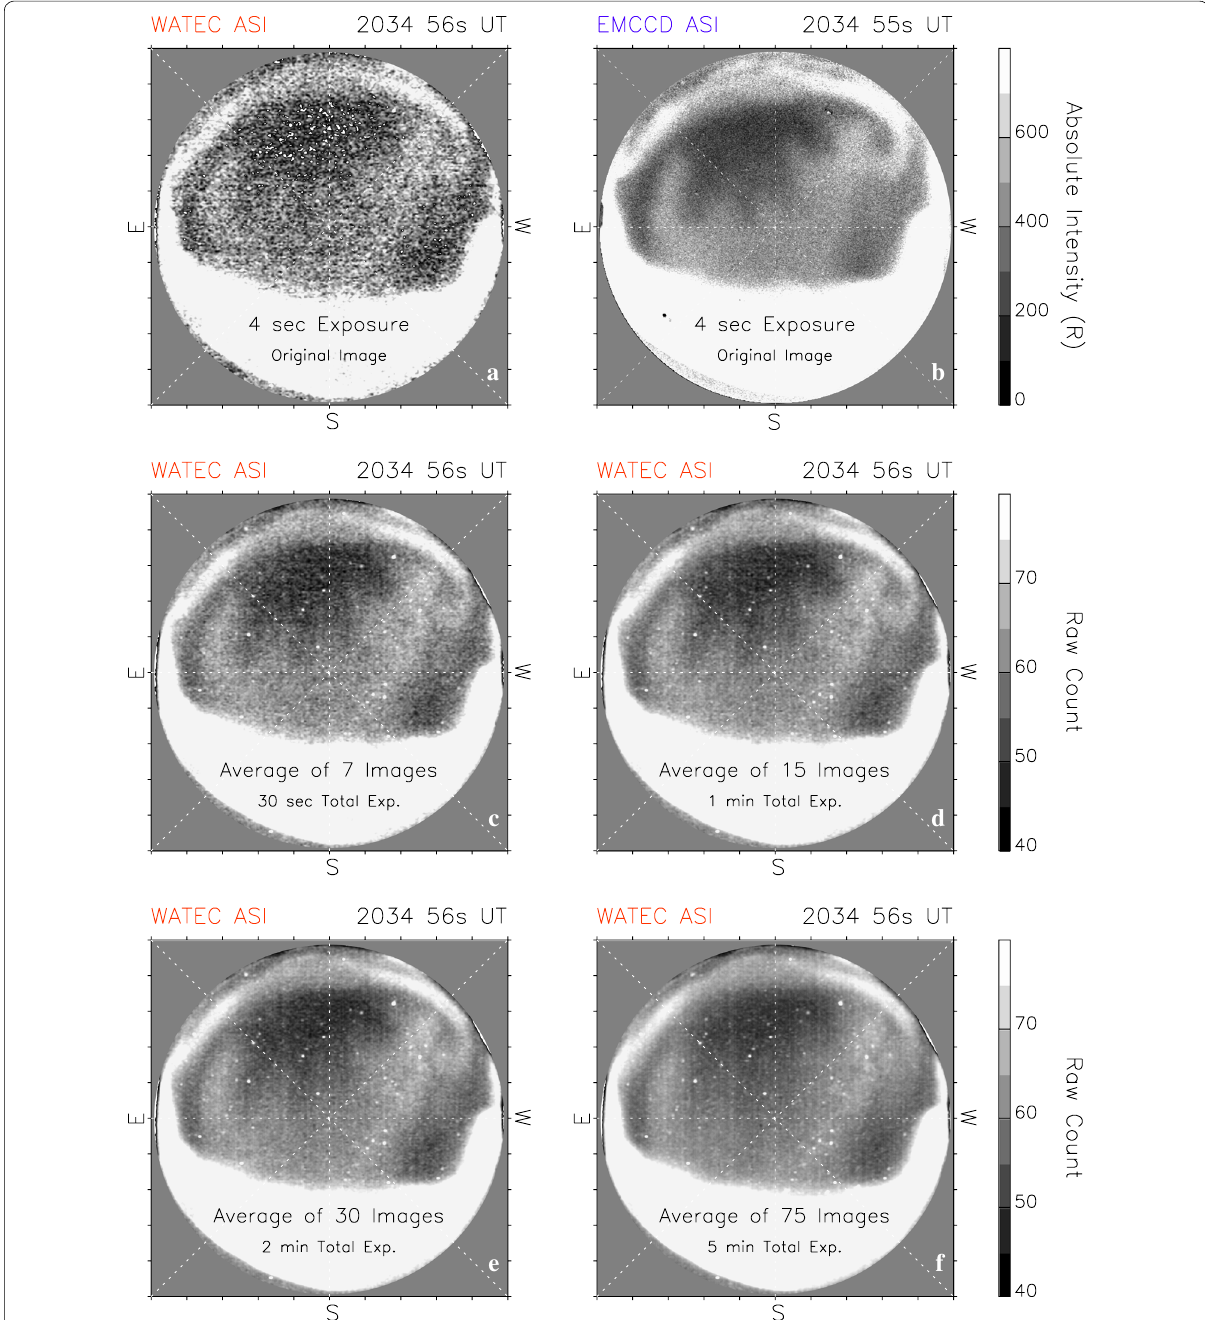
Fig. 2 Summary of the image processing, a raw image from the WATEC ASI at around 20:35 UT on December 4, 2013, b absolute optical intensity image from the EMCCD ASI obtained almost simultaneously, c average of seven raw images (total exposure time ~ 30 s) from the WATEC ASI, d average of 15 raw images (total exposure time ~ 1 min) from the WATEC ASI, e average of 30 raw images (total exposure time ~ 2 min) from the WATEC ASI, and f average of 75 raw images (total exposure time ~ 5 min) from the WATEC